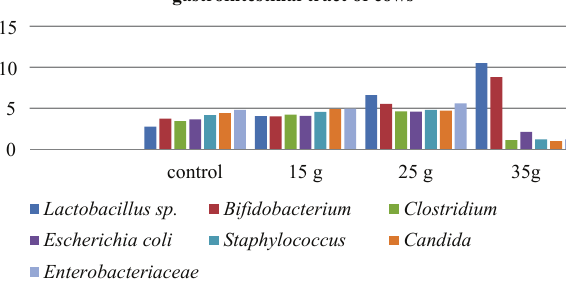
Fig. 1. Influence of Bacillus megaterium on the formation of the microflora of the gastrointestinal tract of